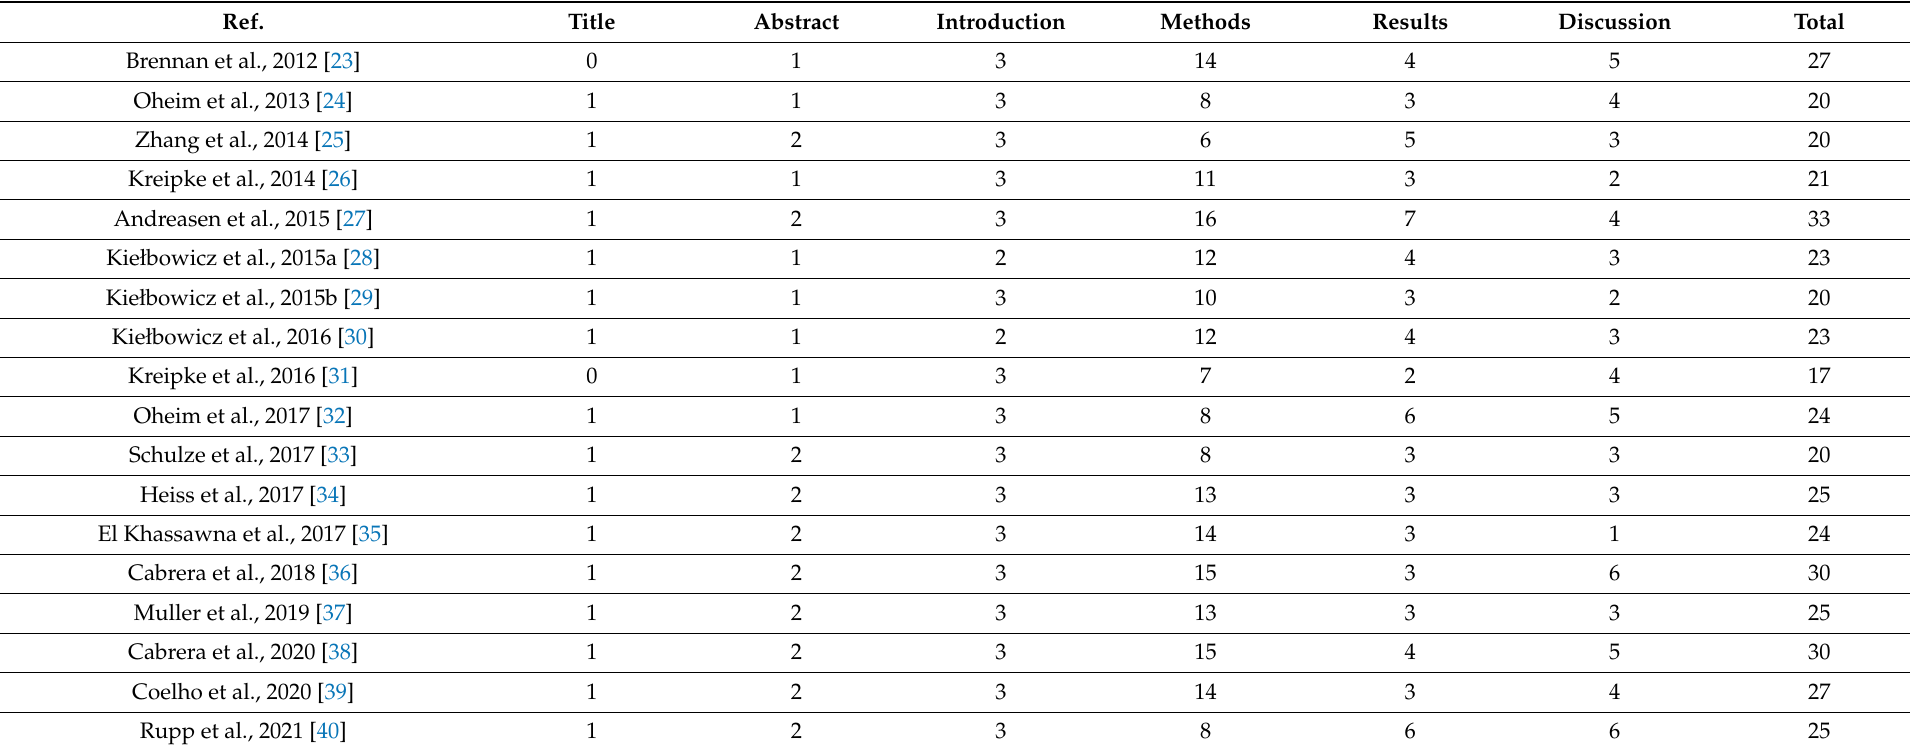
Table 3. Categories to assess the quality of finally selected studies.